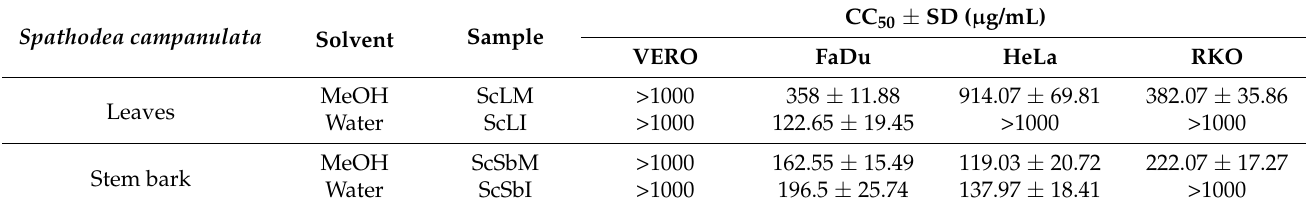
Table 3. Results of cytotoxicity